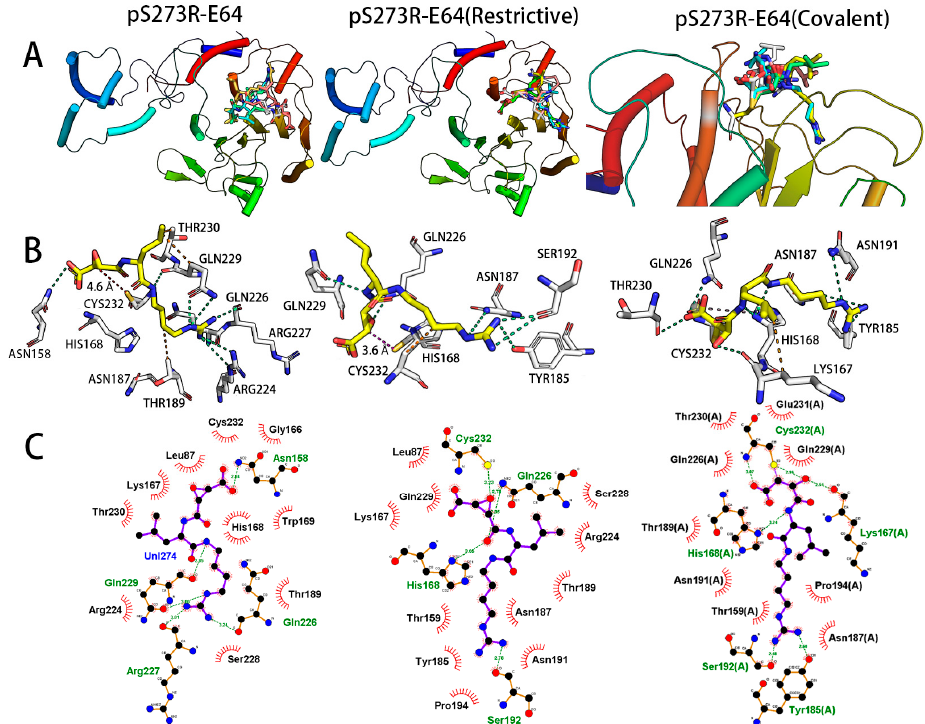
Figure 3. Interaction diagrams of molecular common docking, restricted docking, and covalent docking of pS273R and E64. ( A ) Docking pose of E64 molecules with top five docking scores in pS273R. ( B ) The interaction of E64 molecules with amino acids in the active pocket of pS273R mapped using the open-source version of Pymol 2.6. Hydrogen bonds are shown in green and hydrophobic interactions in yellow. The carbon skeleton of the E64 molecule colored yellow, the amino acid carbon skeleton is colored white, the nitrogen atoms are colored blue, and the oxygen atoms are colored red. ( C ) The 2D interaction of E64 molecule with amino acids in the active pocket of pS273R was plotted using the EDU version of LigPlot+ v.2.2. The carbon backbone of the inhibitor molecule is shown in purple, nitrogen atoms in blue, oxygen atoms in red, residues involved in hydrogen bond interactions named in green, and residues in red named as those that provide pockets and hydrophobic interactions.